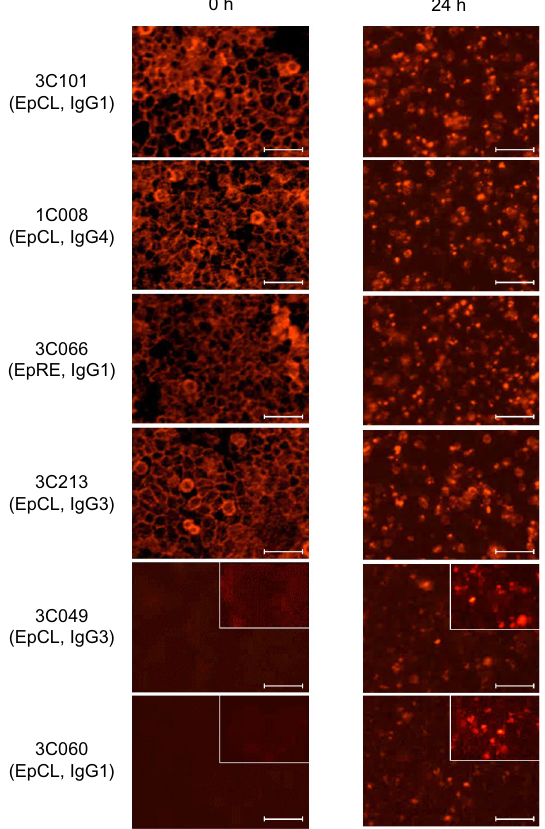
Figure 5. Internalization analysis of anti-EpCAM fully human mAbs. HCT116 cells were stained with the indicated mAbs followed by anti-human IgG-Fc antibody conjugated with Alexa Fluor 594 (The Jackson Laboratory, Bar Harbor, ME, USA) at a dilution of 1:600 and analyzed using IncuCyte S3 (Sartorius, Göttingen, Germany). Fluorescent images taken immediately after the start of incubation at 37 °C for 0 h (left side) and after 24 h of incubation (right side) are shown. Scale bar = 50 μm. Magnification ×